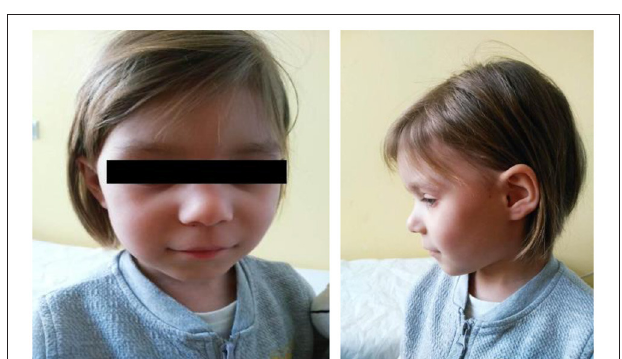
FIGURE 1 | The face of the patient with a new pathogenic variant NM_001256182.1:c.5117delC NP_001243111.1:p.Pro1706LeufsTer13 in one copy of ANKRD11 gene. Note a characteristic facial features: typical triangular face, wide eyebrows, synophrys, prominent nasal bridge, thick alae nasi.